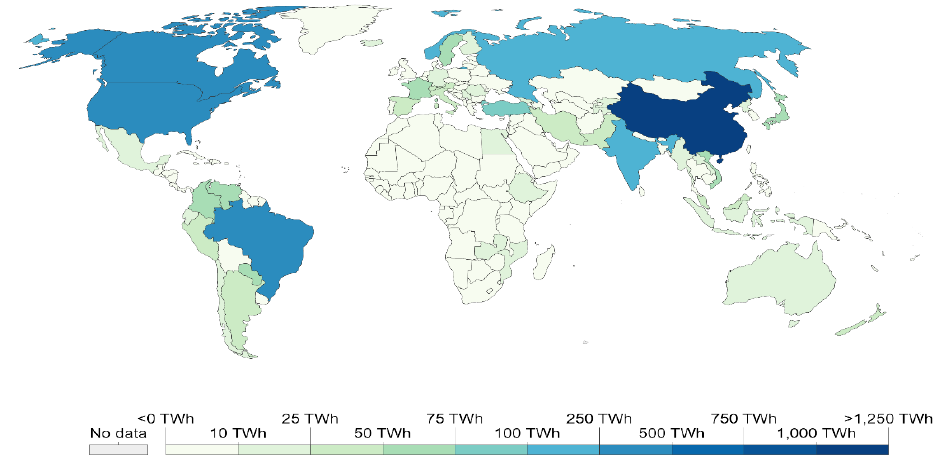
Figure 8. A global map highlights the annual hydropower generation in terawatt-hours (TWh) for the year 2019 [76] (Data source: British Petroleum (BP) Statistical Review of World Energy, 2020).